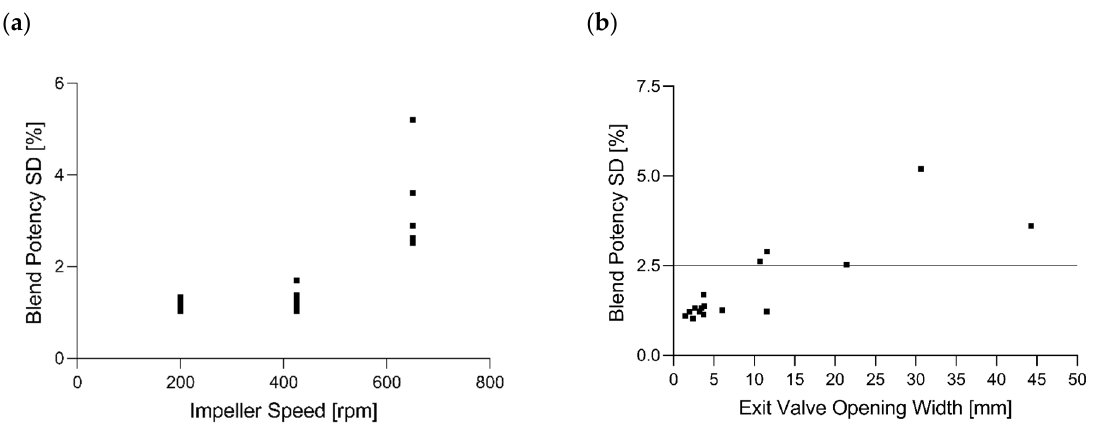
Figure 15. Blend Potency SD as a function of ( a ) impeller speed and ( b ) exit valve opening width.